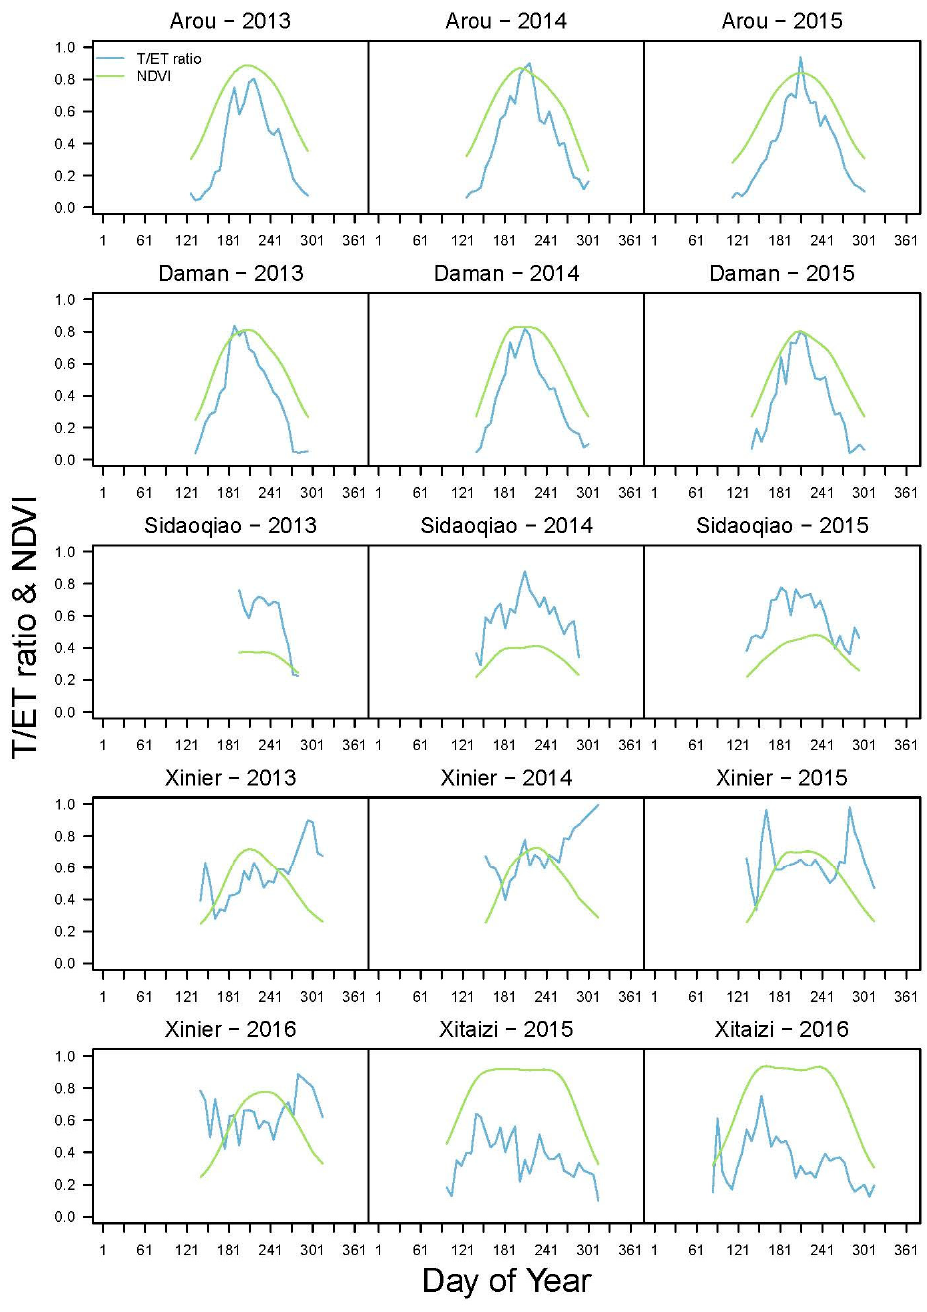
Figure 9. Seasonal dynamic of weekly T/ET ratio.